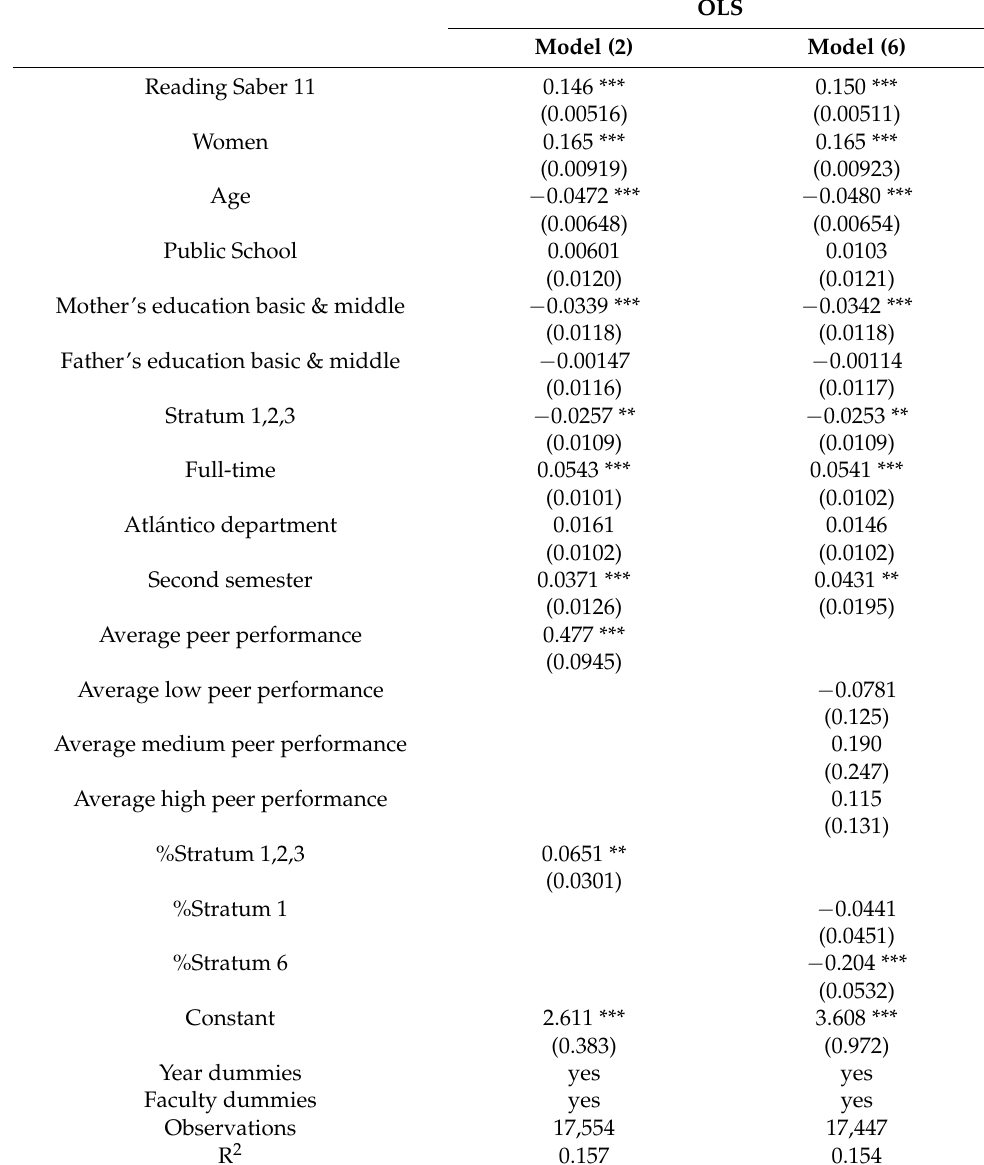
Table 7. Peer effects on academic performance in Communication Skills